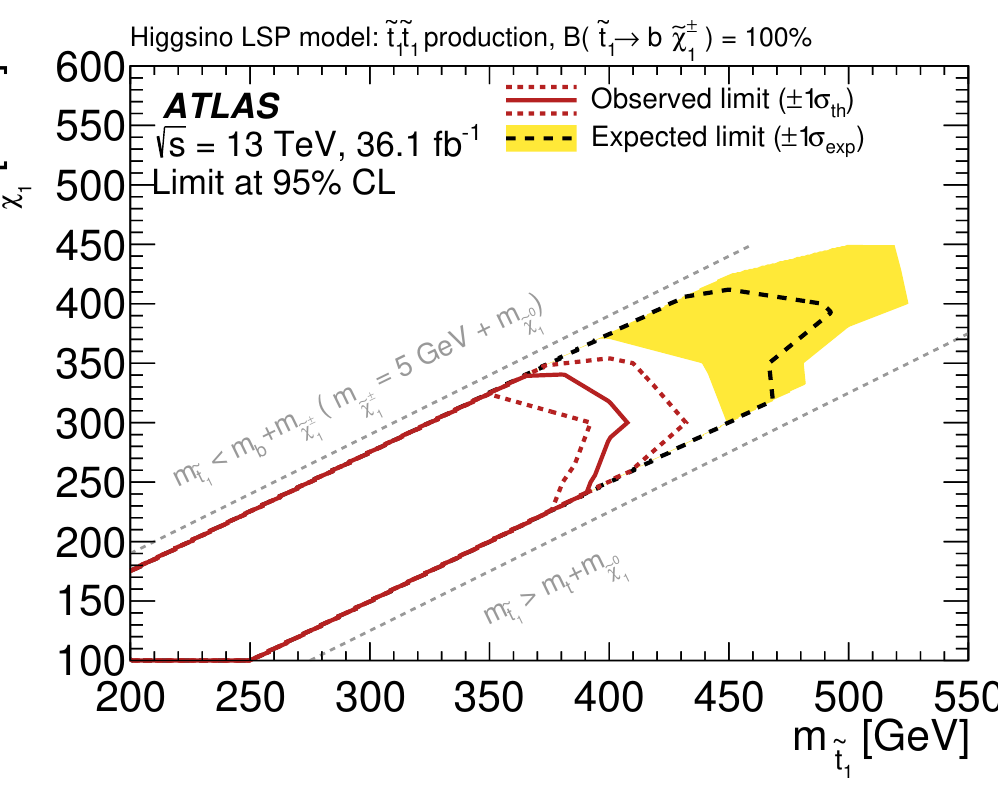
Figure 26 . Expected (black dashed) and observed (red solid) 95% excluded regions in the plane of m versus m ~ for direct stop pair production in the higgsino LSP model where only the t 1 ~ (cid:31) 0 1 (cid:6) ~ t b ~ (cid:31) 1 decay mode is kinematically allowed due to the phase space constraint. In this model, 1 ! (cid:6) ~ (cid:31) 0 (cid:1) m (~ (cid:31) 1 ) = 5 GeV is 1 ;